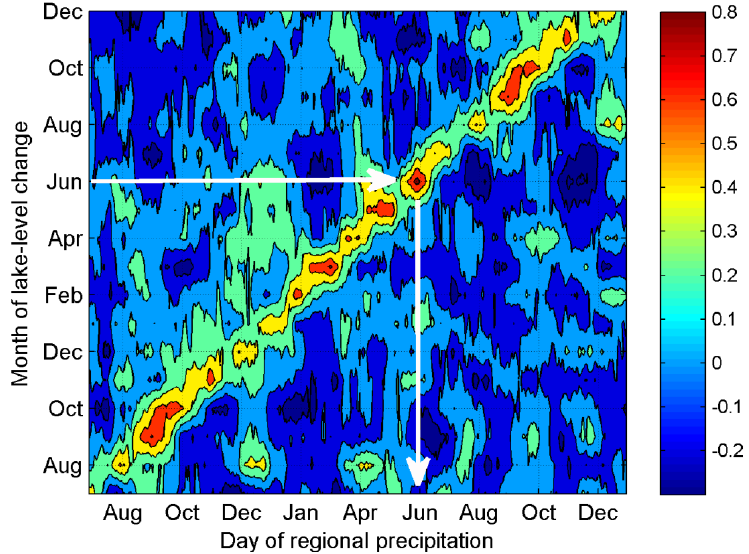
Figure 4. Correlations between regional precipitation (cid:1842) (cid:3031)(cid:3045) that begin on the dates along the horizontal axis, and monthly lake-level changes (cid:1856)(cid:1838) (cid:3040),(cid:3052)(cid:3008) that occur during the months along the vertical axis. The shading indicates the strength of correlation ( r ), as indicate by the bar on the right. The average r -values which significantly exceed zero are 0.45 ( p < 0.05) and 0.55 ( p < 0.01). See text for further